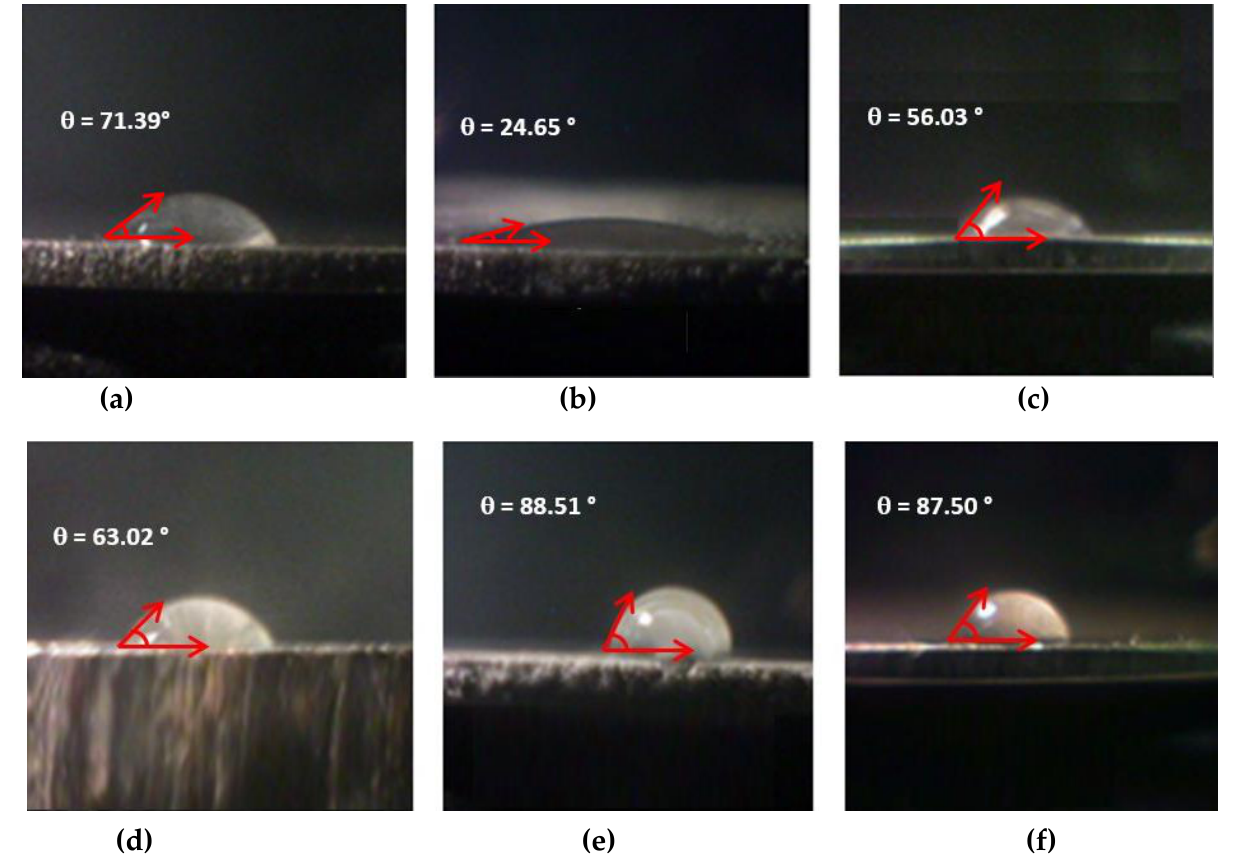
Figure 10. Comparison of contact angles θ w and θ Y of ( a ) Ti, ( b ) Ti-OH, ( c ) Ti-AEMAC, ( d ) Ti-GTMAC,